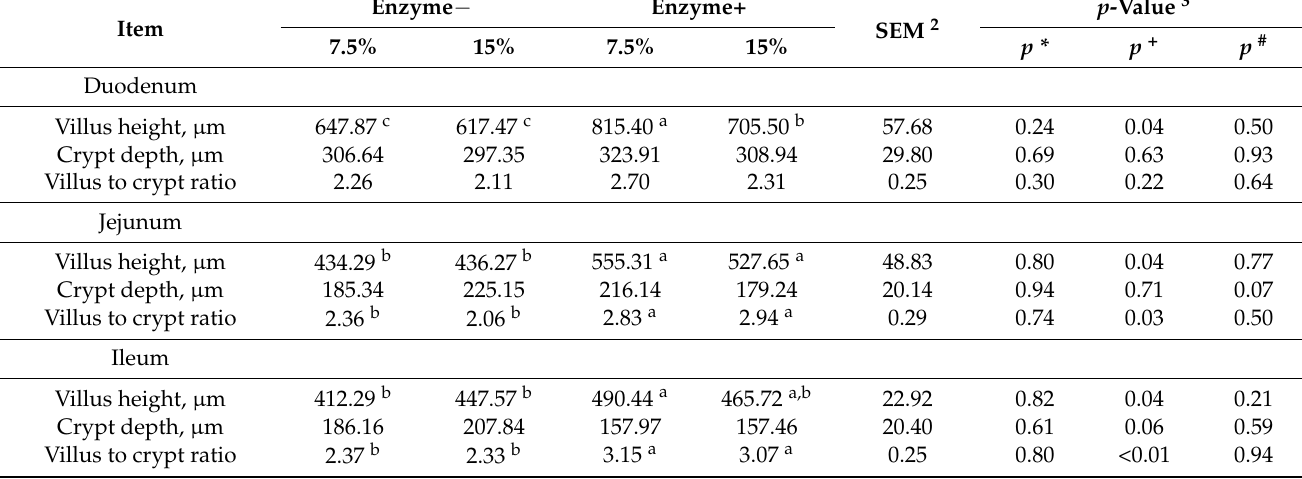
Table 7. Effects of different moisture contents (adding 7.5 vs. 15% water) and enzyme